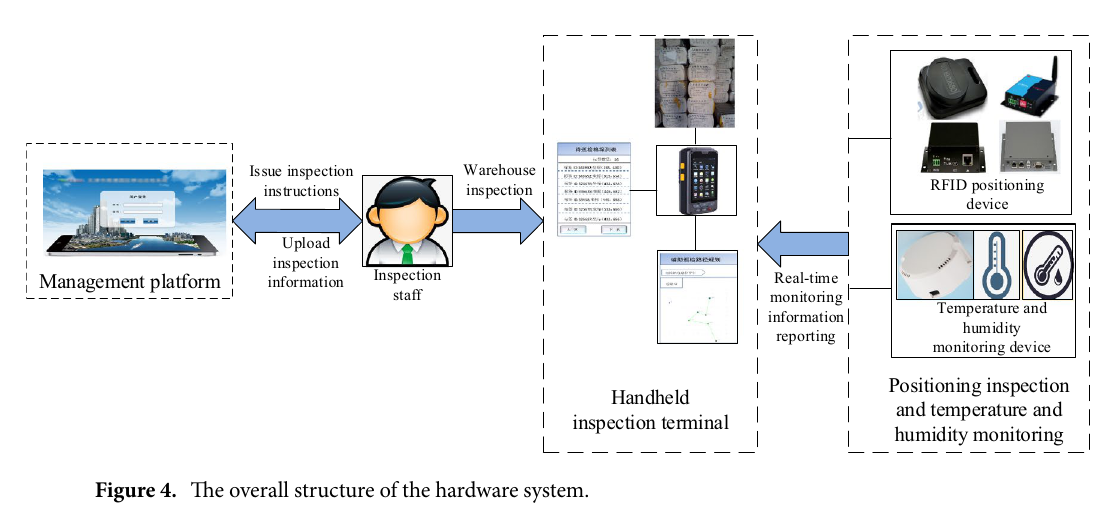
Figure 4. The overall structure of the hardware